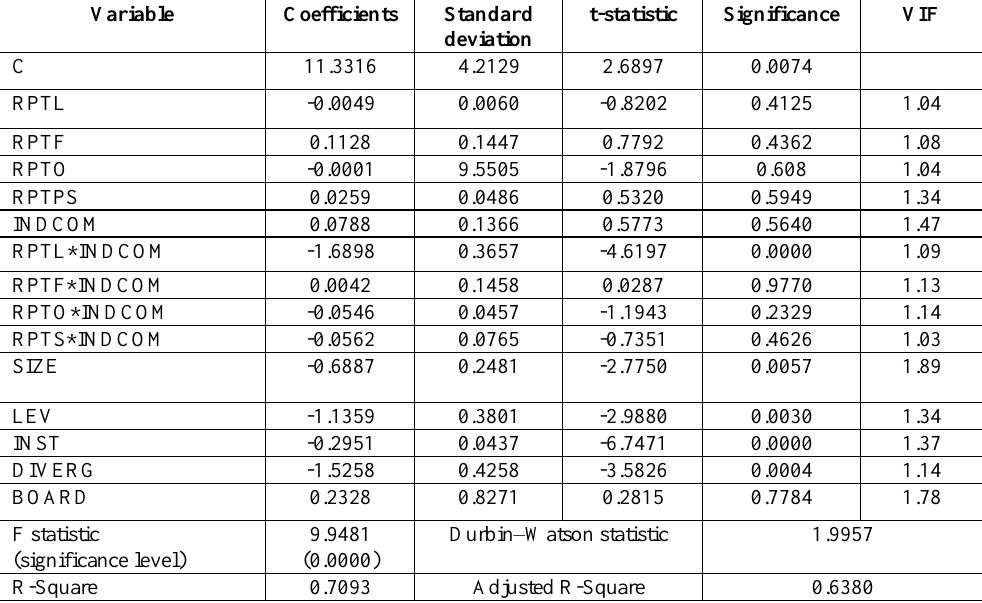
Table 7. The results of the fourth model (dependent variable is market